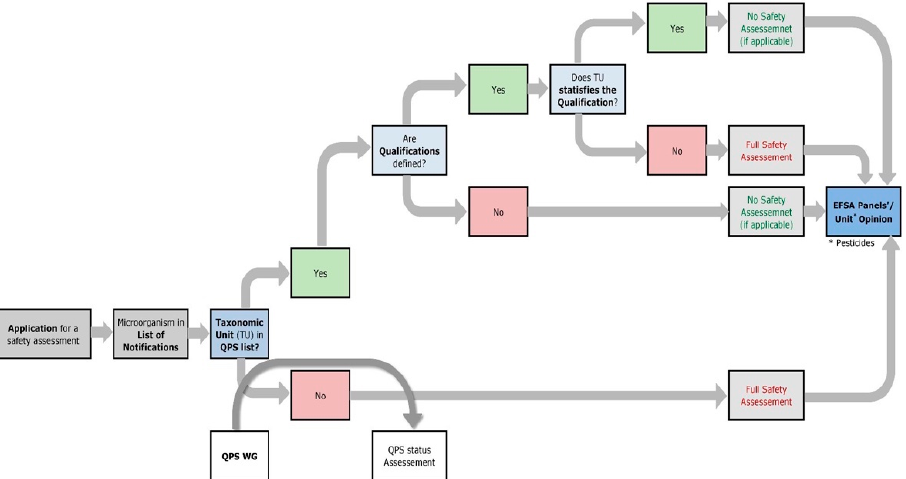
Figure 3. Workflow diagram describing how EFSA Units incorporate the qualified presumption of safety (QPS) status (from Herman et. al. under CC BY 4.0 conditions) [135]. safety (QPS) status (from Herman et. al. under CC BY 4.0 conditions)